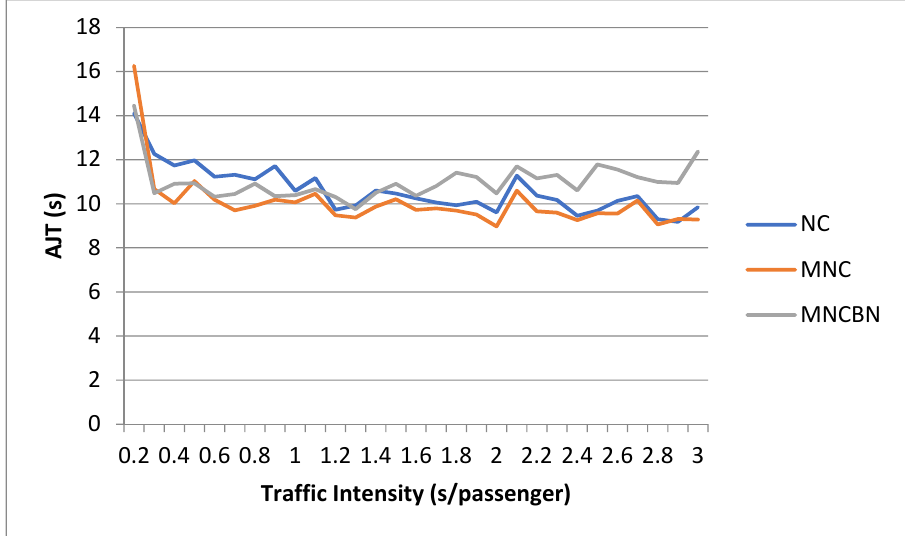
Figure 9. Dependence of AJT on change in traffic intensity.